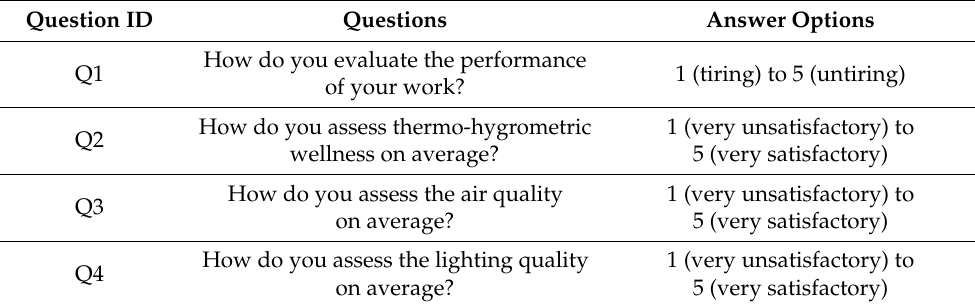
Table 3. Questions of Web-based